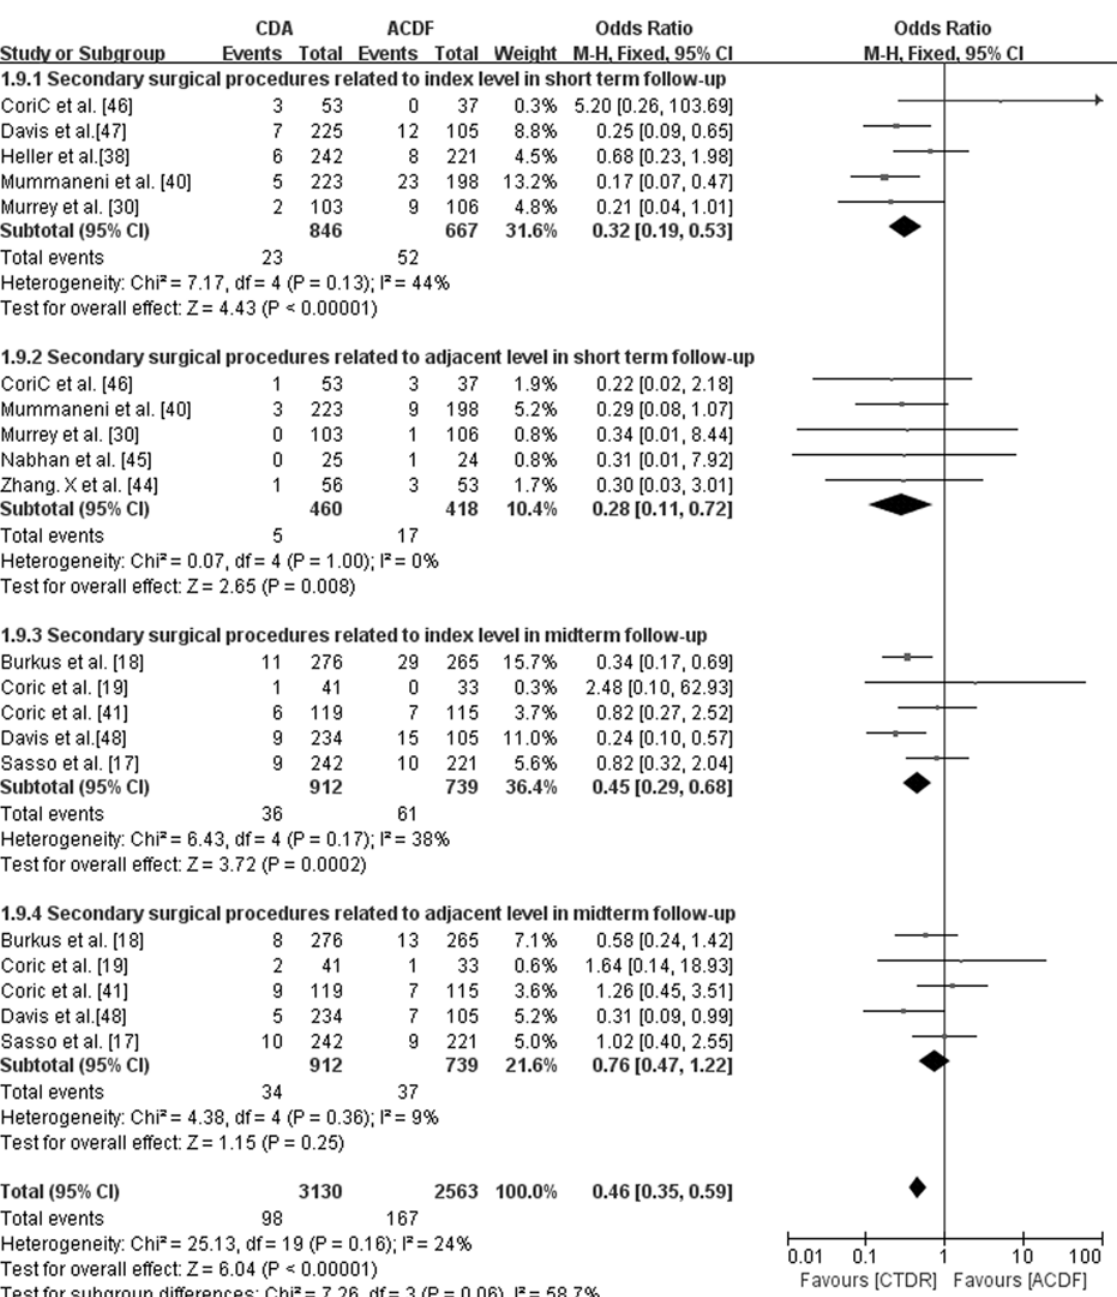
Fig 7. Comparison of Secondary surgical procedures between the cervical total disc replacement (CTDR, experimental) group and the fusion (ACDF, control) group. MH = Mantel-Haenszel, CI = confidence interval, and df = degrees of